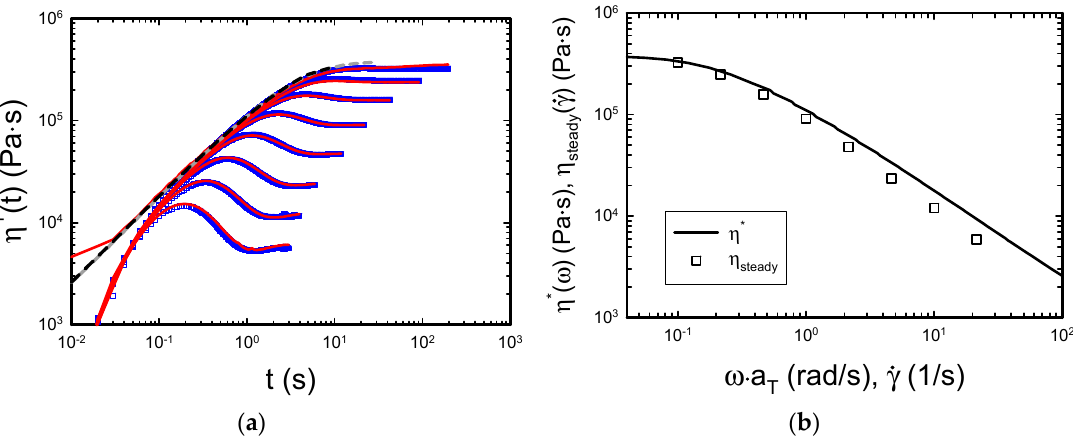
Figure 6. ( a ) Transient viscosity measurements performed with CPP6 (empty blue squares) and CPP4 (red lines) at T = 160 ◦ C; shear rates from top to bottom: 0.1, 0.215, 0.464, 1, 2.15, 4.64, 10, 21.5 s − 1 . The linear viscoelastic envelope is also reported (dashed grey line and dashed black line). ( b ) Cox-Merz rule applied to the transient data.